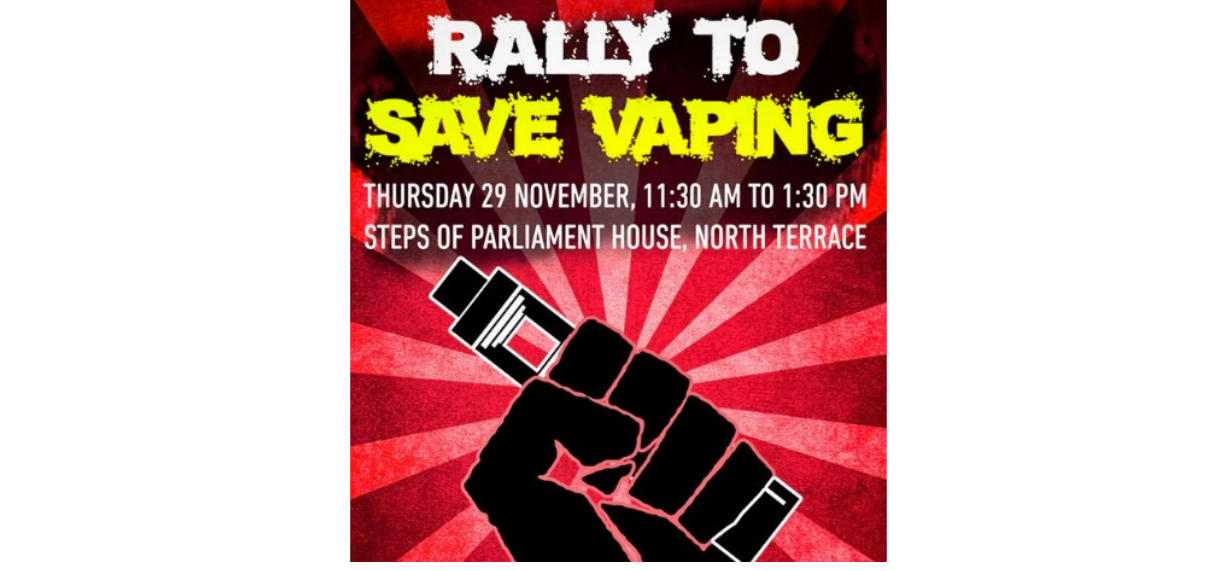
Figure 12. Example of advocacy within the "regulation and advocacy"